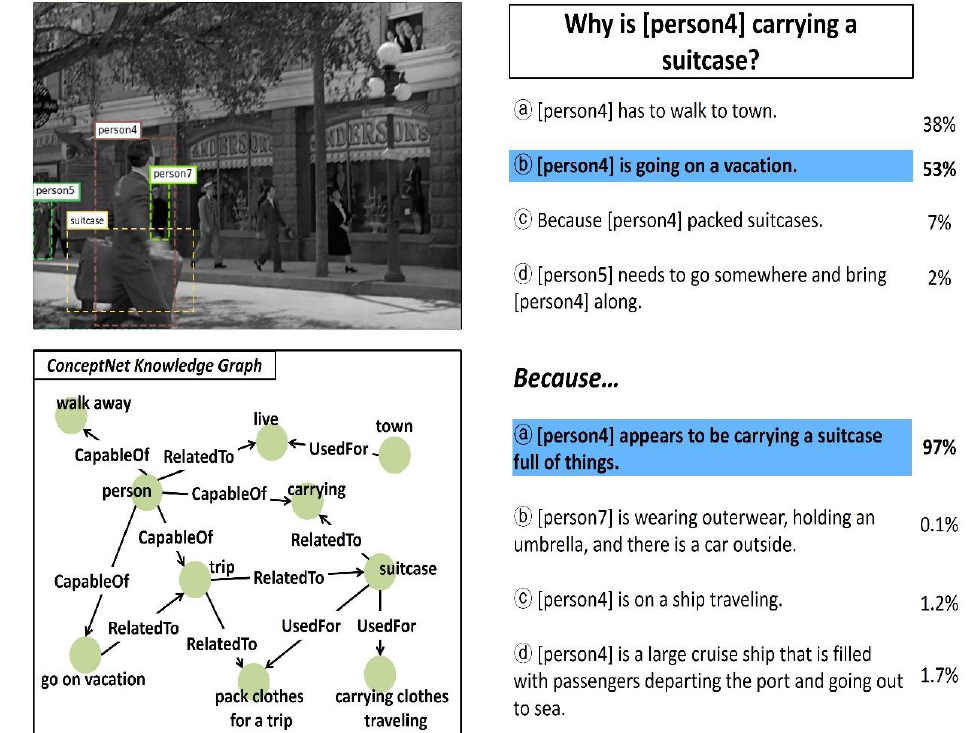
Figure 10. The second example of VCR task performed by the proposed model. Sensors 2021 , 21 , x FOR PEER REVIEW